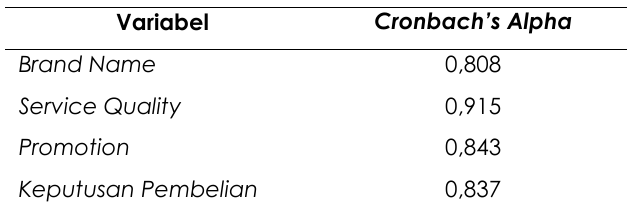
Tabel 5. Cronbach’s